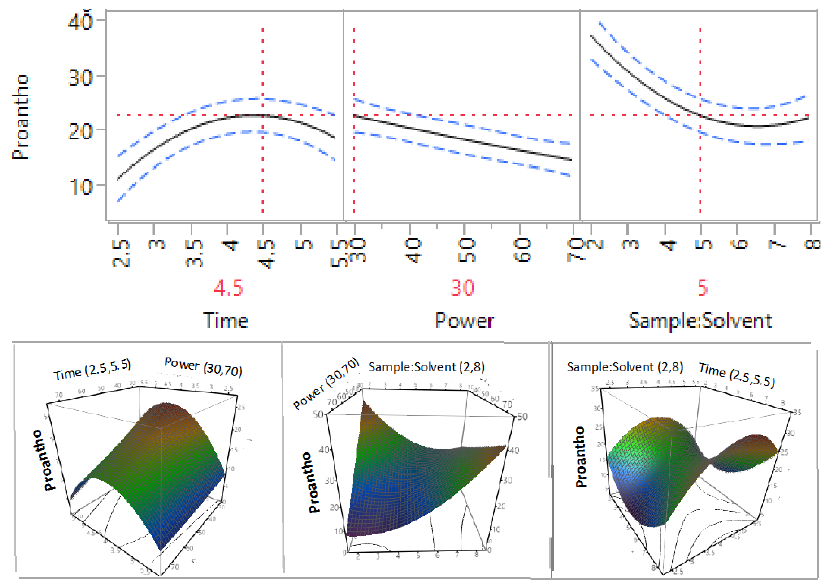
Figure 6. Impact of time (2.5–5.5 min), power (30%–70%, 360–840 W) and sample-to-solvent ratio (2–8 g/100 mL) on proanthocyanidins (mg CAE/g).